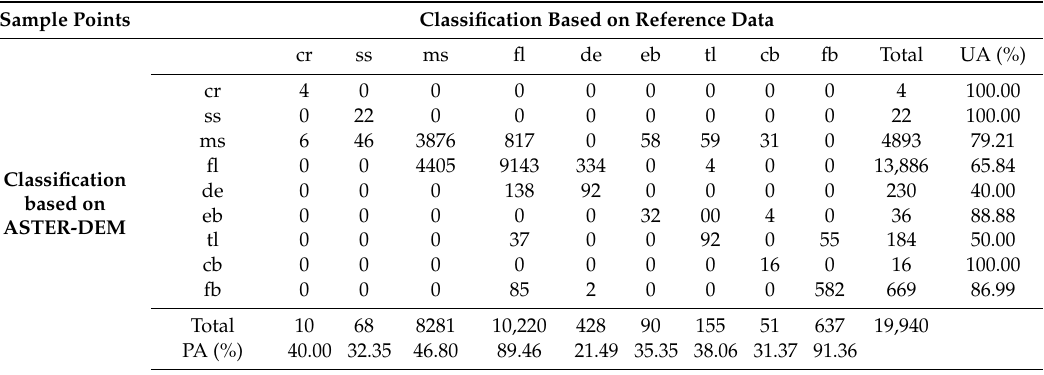
Table 7. Confusion matrix for landform classification based on the ASTER-DEM and reference data (sample points) set for whole study area. Where cr is crest, ms is moderate hillside slope, ss is steep hillside slope, fl is flat land (unspecified), de is depression (open, closed), eb is embankment, tl is terraced land, cb is channel bank and fb is